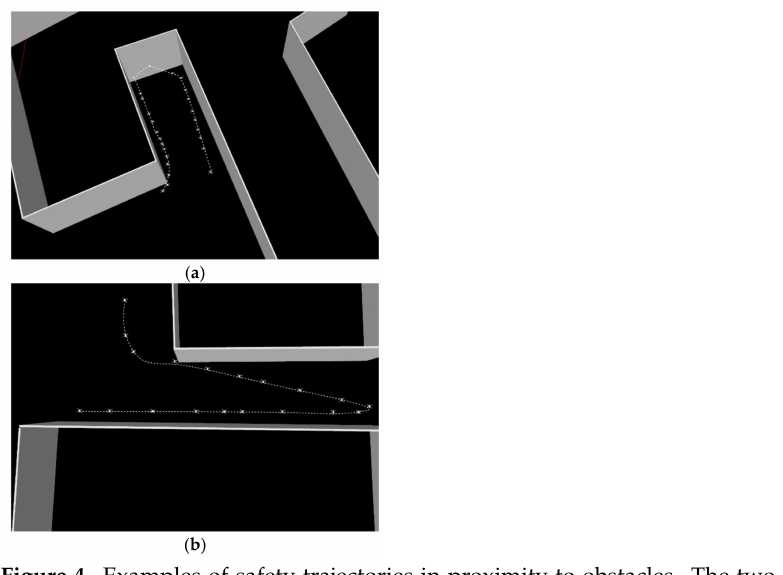
Figure 4. Examples of safety trajectories in proximity to obstacles. The two scenarios presented in subfigures ( a , b ) display the ability of the UAV to avoid collisions and safely navigate inside narrow